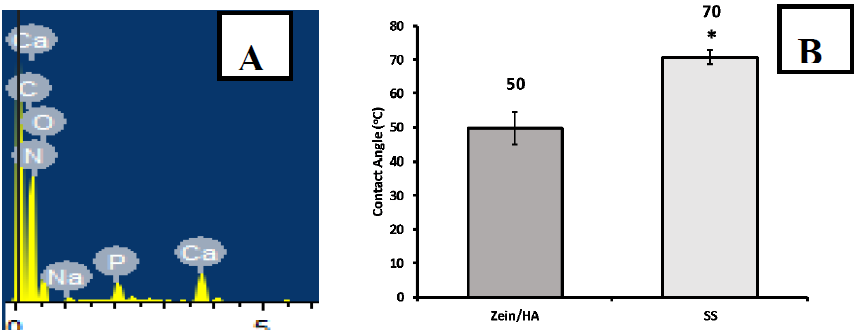
Figure 3. ( A ) EDX Spectrum; ( B ) Contact Angle comparison with a stainless steel substrate of zein/ HA coatings obtained via EPD (parameters: 5 g/L HA in the suspension, 3 min, 15 V) (* significant at p < 0.05). The data represents the mean ± standard deviation of five experiments for each system.